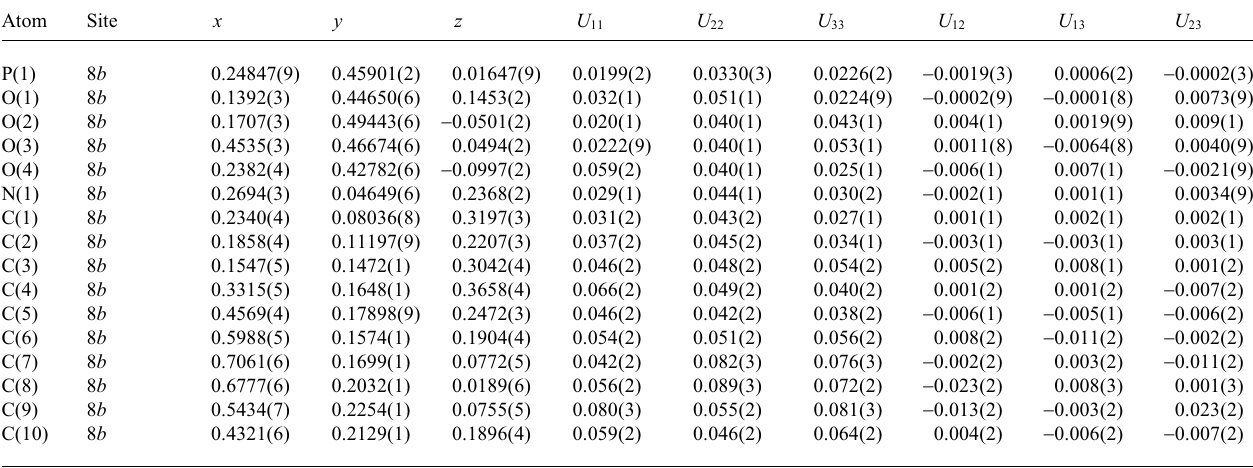
Table 3. Atomic coordinates and displacement parameters (in Å 2